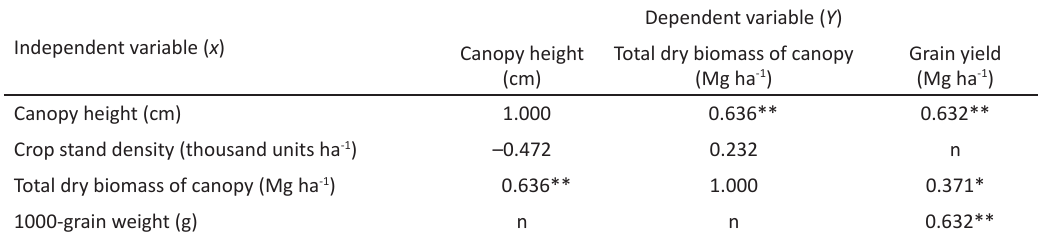
Table 12. Correlation between the maize productivity parameters in